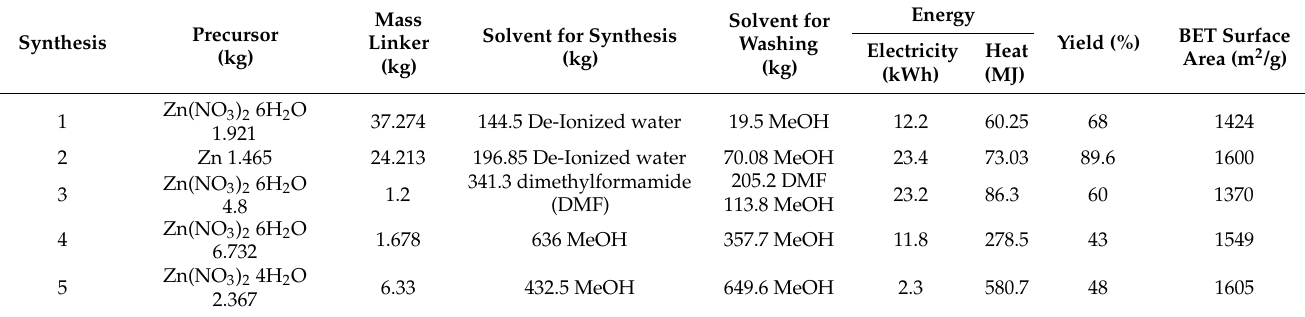
Table 1. Details of the synthetic routes for the production of 1 kg